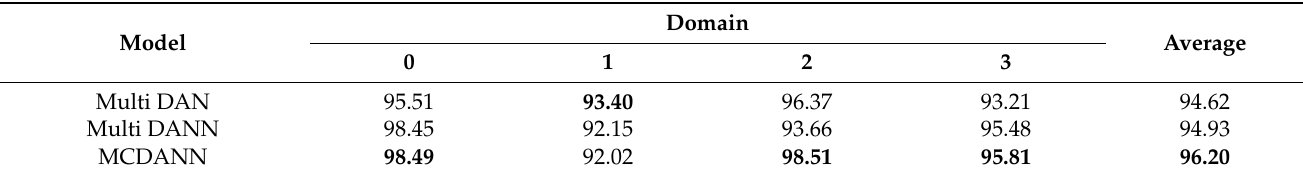
Figure 10. DIRG classification accuracy comparison of three multi-source domain adaptation models on unknown working conditions without labels. (SNR = − 4, static load = 1000 N). Table 4. DIRG classification accuracy of different models on unknown working conditions without labels. (SNR = − 4, static load = 1000